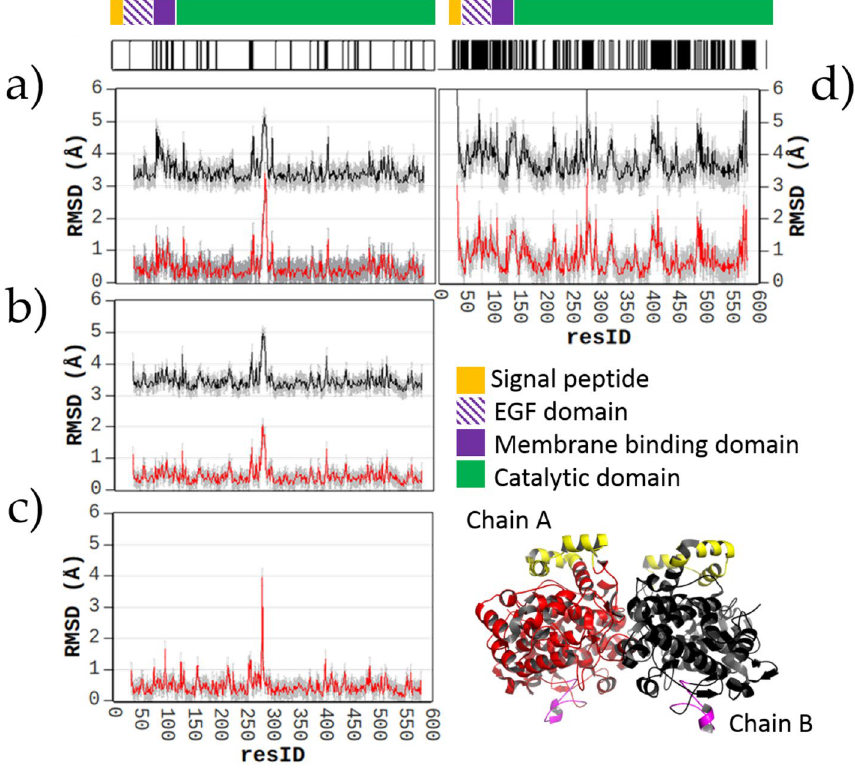
Figure 7. Average residue-by-residue RMSD values calculated after superposition of h COX-1 (6Y3C) with ( a ) o COX-1 crystallized in the I 222 space group (PDB codes 1Q4G, 2AYL, 1PTH, 1PRH, 1PGG, 1PGE, 1PGF, 1HT8, 1EQH, 1HT5, 1CQE, 1EBV, 1EQG), ( b ) o COX-1 crystallized in the P 6 5 space group (PDB codes 3KK6, 3N8Z, 3N8X, 5WBE, 3N8V, 4O1Z, 3N8Y, 3N8W, 5U6X), ( c ) o COX-1 crystallized in the P 6 5 22 space group (PDB codes 1U67, 2OYE, 2OYU, 1IGZ, 1DIY, 1FE2, 1IGX), and ( d ) h COX-2 crystallized in the I 222 space group (PDB codes 5F19, 5IKQ, 5IKT, 5KIR, 5F1A, 5IKR, 5IKV, 5KIR) to the h COX-1 (6Y3C) crystal structure. Standard deviation for each residue is shown in gray color. RMSD values related to chain A and chain B (nomenclature refers to that adopted for 5U6X shown at bottom right in the figure) are shown in red and black, respectively. Here, regions 70–110 and 270–290 are shown in yellow and magenta color. In the case of o COX-1 crystallized in P 6 5 22, the biological unit contains a homo-conformational dimer, therefore only chain A is shown. The numbering of residues refers to h COX-1 structure. On the top of the figure, variations between h COX-1 and o COX-1 (left) and h COX-2 (right) are shown, along with h COX-1